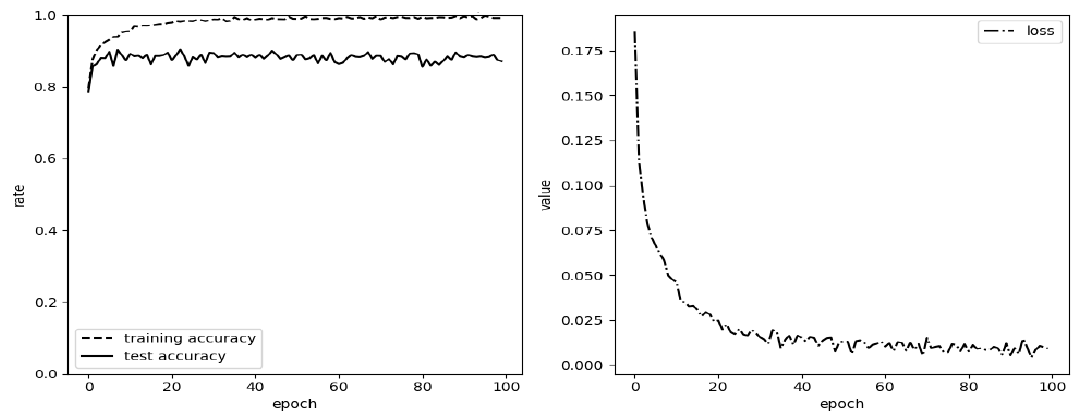
Figure 14. The Accuracy and Loss of ResNet_2d Vary with Epochs. The ( left ) panel is the train and test accuracy of ResNet_2d within 100 epochs and the ( right ) panel is the loss value of ResNet_2d within 100 epochs.